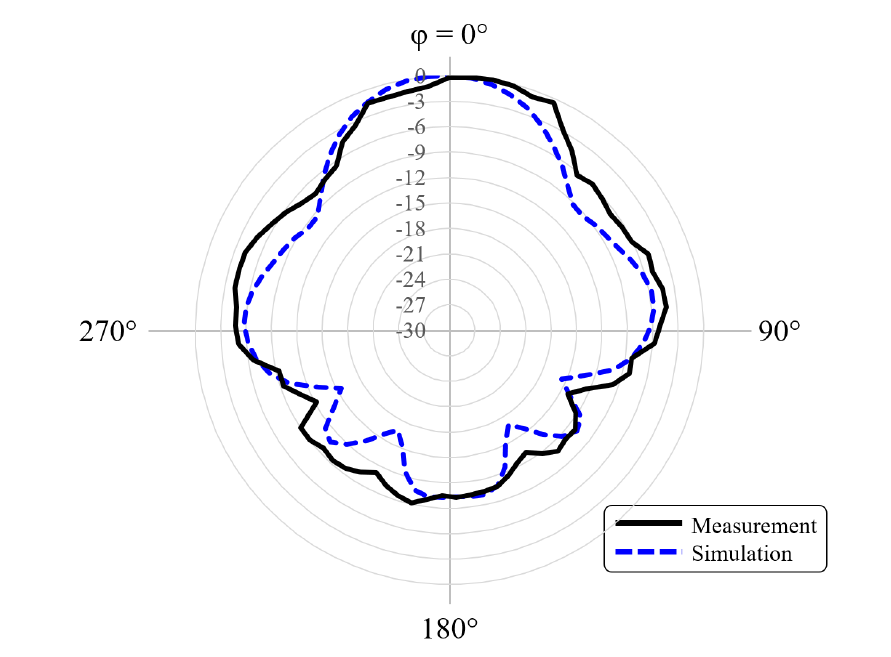
Figure 9. The comparative results for the measured (solid-black curve) and simulated (dashed-blue line) radiation patterns at a 5.7GHz operating frequency. The results in this figure consider the use of the proposed quasi–cylindrical Bragg structure.